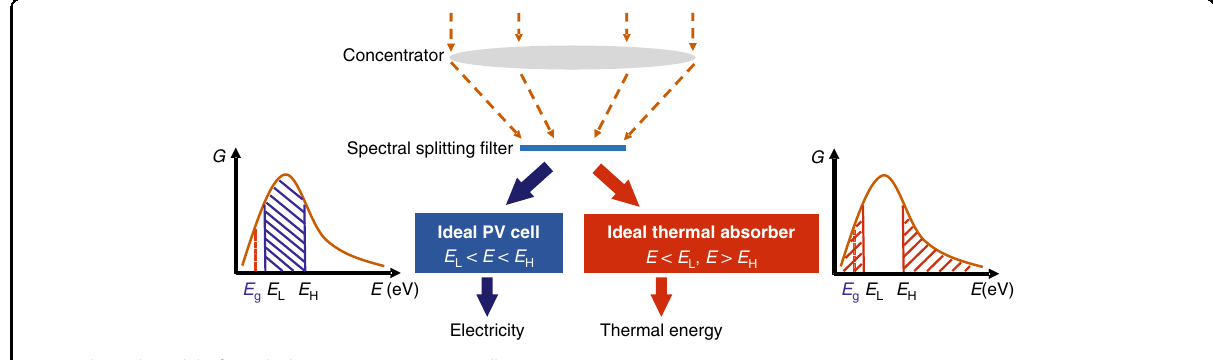
Fig. 2 Physical model of an ideal concentrating SSPVT